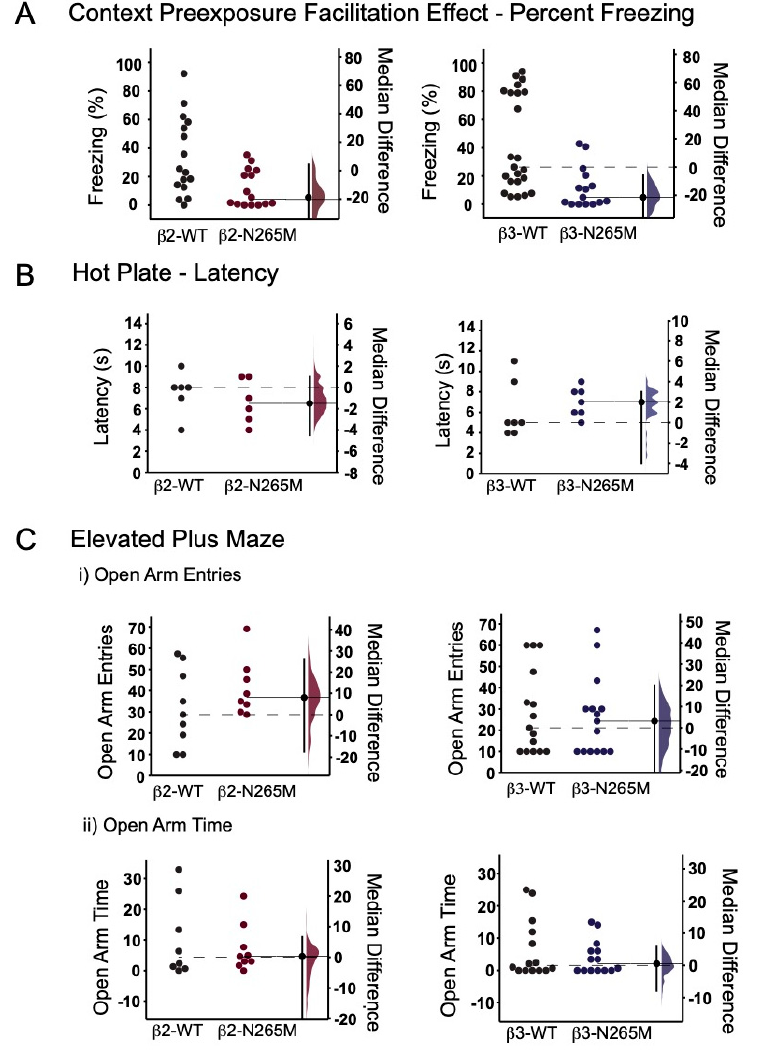
Figure 1. Behavioral characterization of β 2-N265M and β 3-N265M mice under drug-free conditions. Data are presented using Gardner-Altman estimation plots; the left axis applies to individual observations, and the right axis applies to median differences and its bootstrap sampling distribution. The median distance is shown as a large dot; the 95% confidence interval for the median difference is indicated by the ends of the vertical error bar, and in the text below as [min, max]. ( A ) Percentage of time that β 2-N265M (left) and β 3-N265M (right) spent freezing during the day 3 memory test. Both the β 2-N265M and β 3-N265M mice showed impaired memory compared to their WT counter- parts ( p = 0.04 and p = 0.002, respectively, Mann–Whitney U test). ( B ) Latency to nocifensive move-